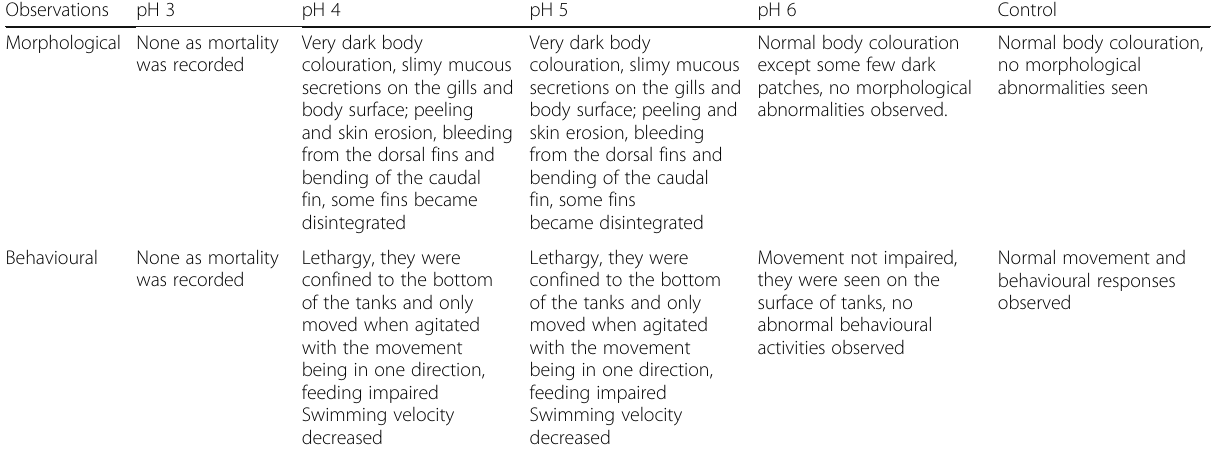
Table 4 Morphological and behavioural observations of fingerling of O. niloticus in low pH and control Observations